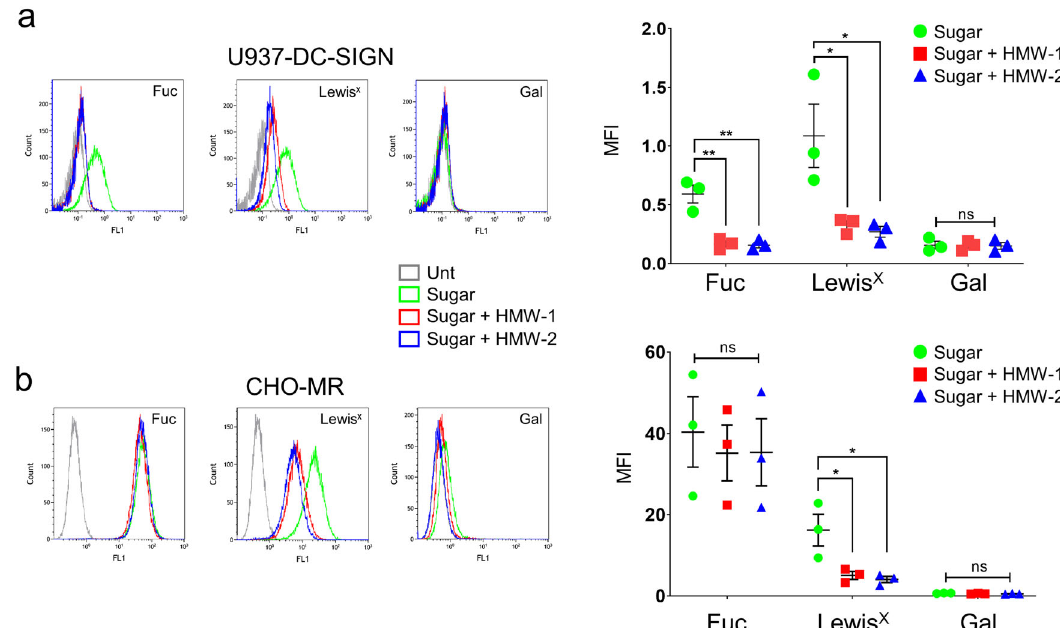
Fig. 4 Inhibition of polymeric ligand uptake by DC-SIGN and MR expressing cells by HMW-1 and HMW-2. Cells were treated with HMW-1 or HMW-2 (10 µg/ml) for 1 h, then fl uorescein-labelled polymeric ligands were added for a further 1 h. The association of fl uorescent polymeric ligands with cells was measured by fl ow cytometry. Representative histograms and scatter plots depicting mean ± SEM of median fl uorescence intensity (MFI) are shown for each cell type. a U937-DC-SIGN cells (express DC-SIGN, but not MR) associated with fucose and Lewis x polymers and this association was reduced by HMW-1 and HMW-2, N = 3. b CHO-MR cells (express MR, but not DC-SIGN) associated with fucose and Lewis x polymers and only Lewis x association was reduced by HMW-1 and HMW-2, N = 3. One-way ANOVA corrected for multiple comparisons using the Tukey ’ s multiple comparisons test. *, ≤ 0.05. ** ≤ 0.01. Fuc fucose, Gal